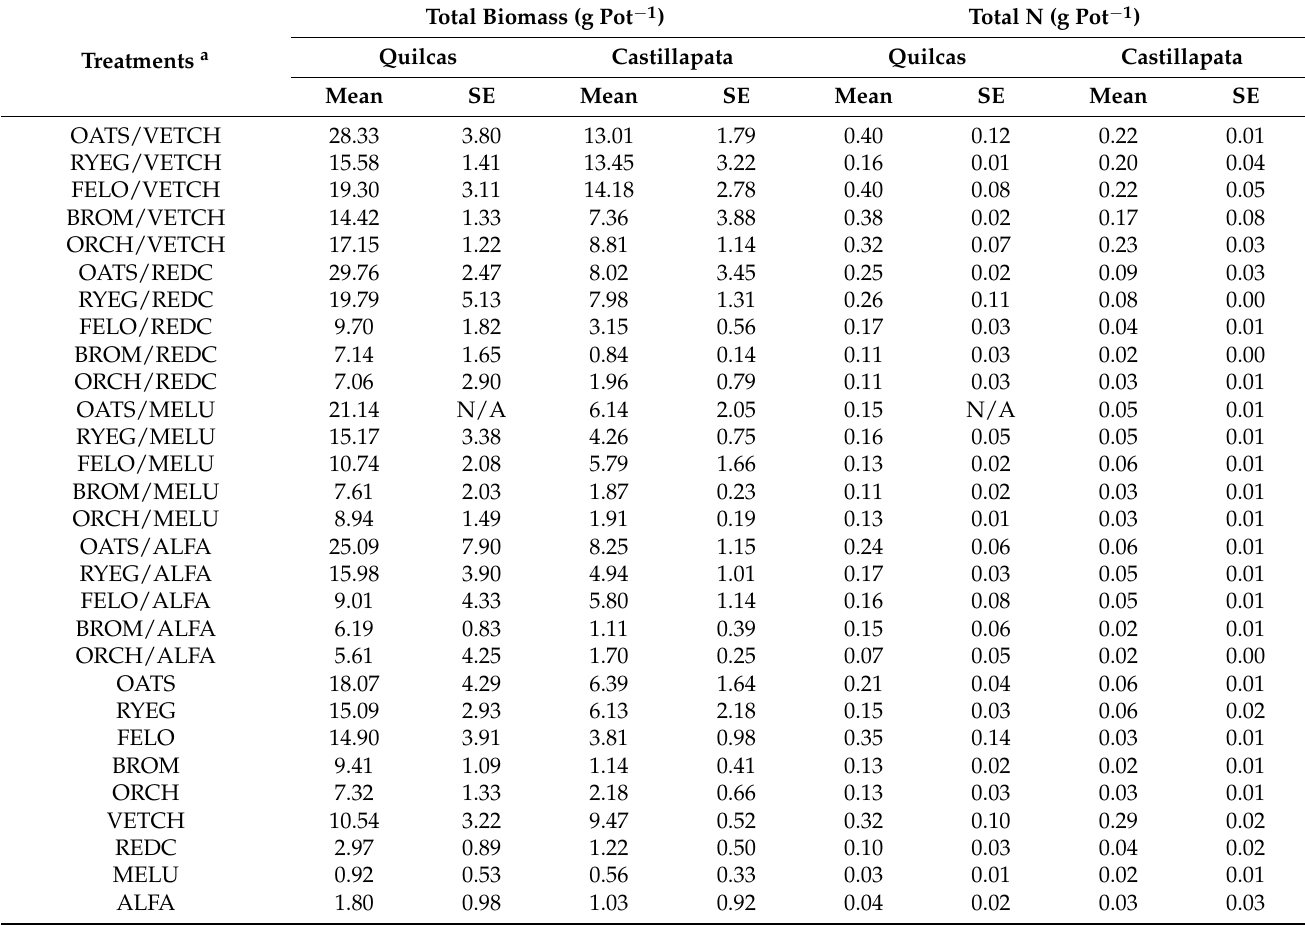
Table 3. Total biomass and total N content (dry weight basis) of grass–legume bicultures and monocultures grown in two soil types (see Table 1). The ANOVA results for each main factor and their respective interaction are presented at the bottom of the table, with significant values ( p < 0.05) in bold. Means and standard errors (SE) correspond to the original data (without transformation), while p -values are based on transformed